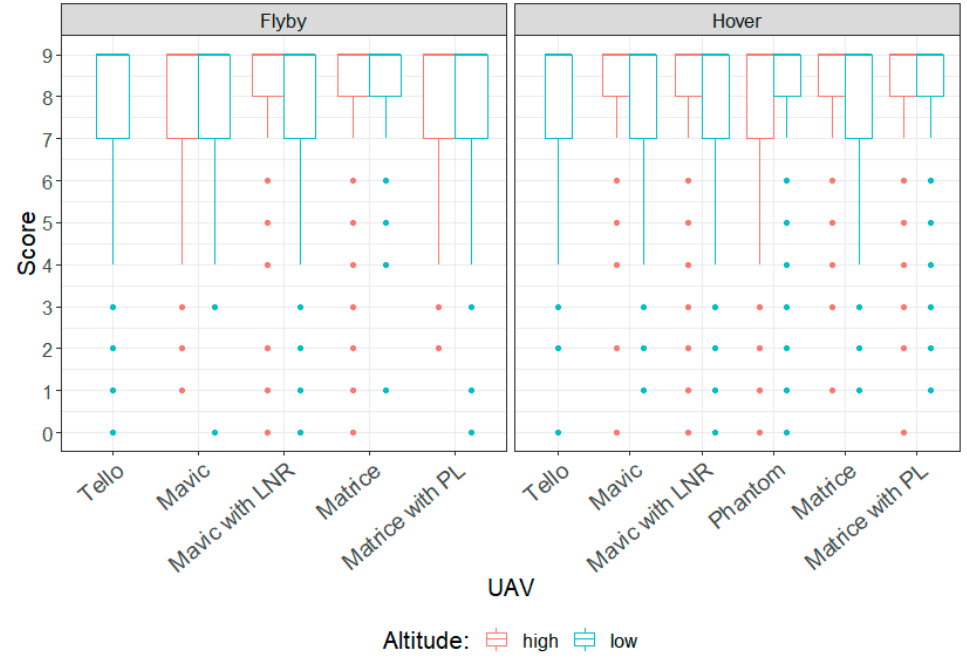
Figure 14. Scores from cognitive distraction test.